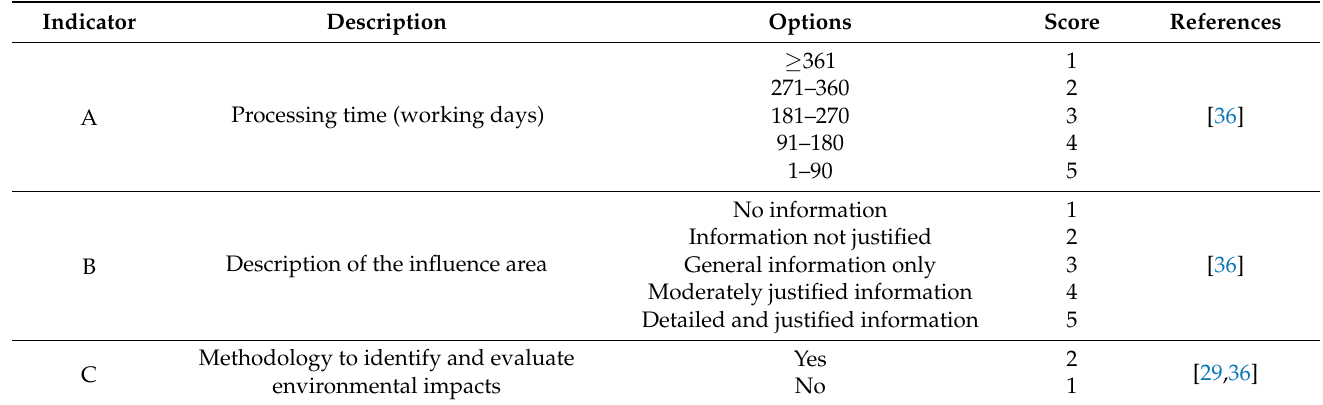
Table 3. Selected indicators to compare samples of sanitation